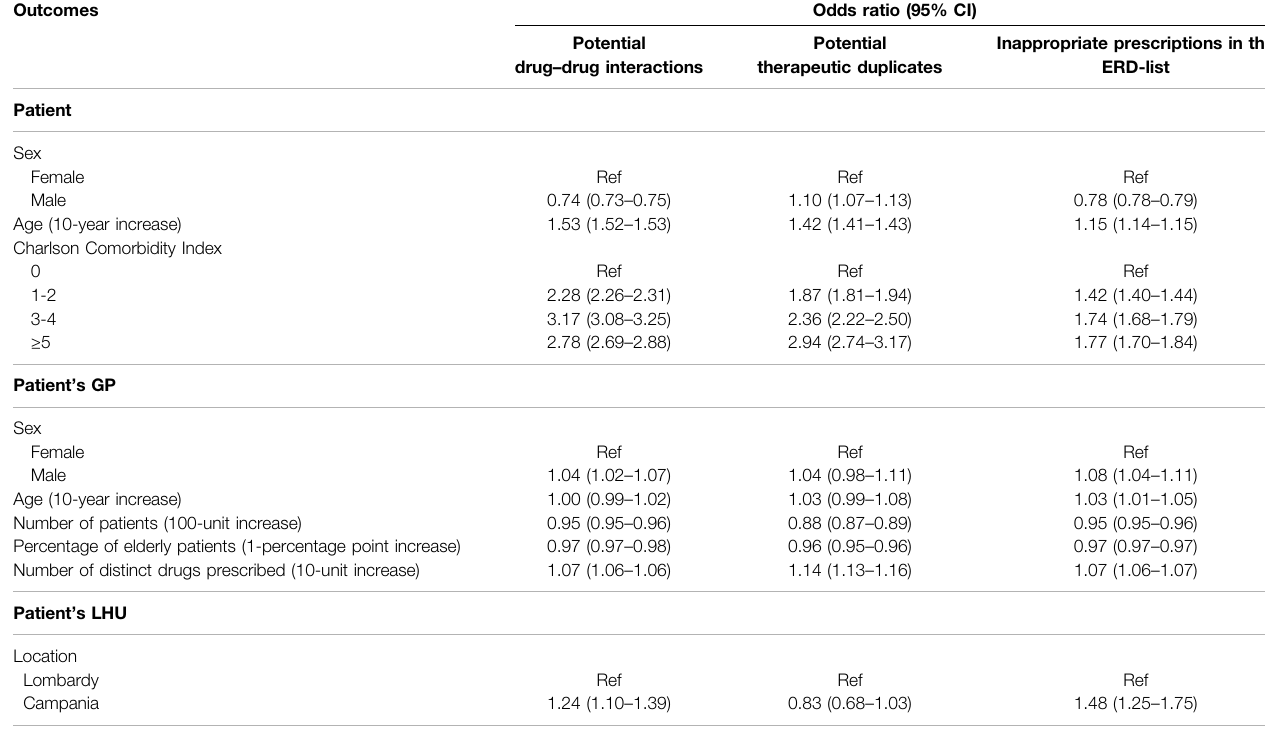
TABLE 2 | Results for the fi xed effects of the fully adjusted